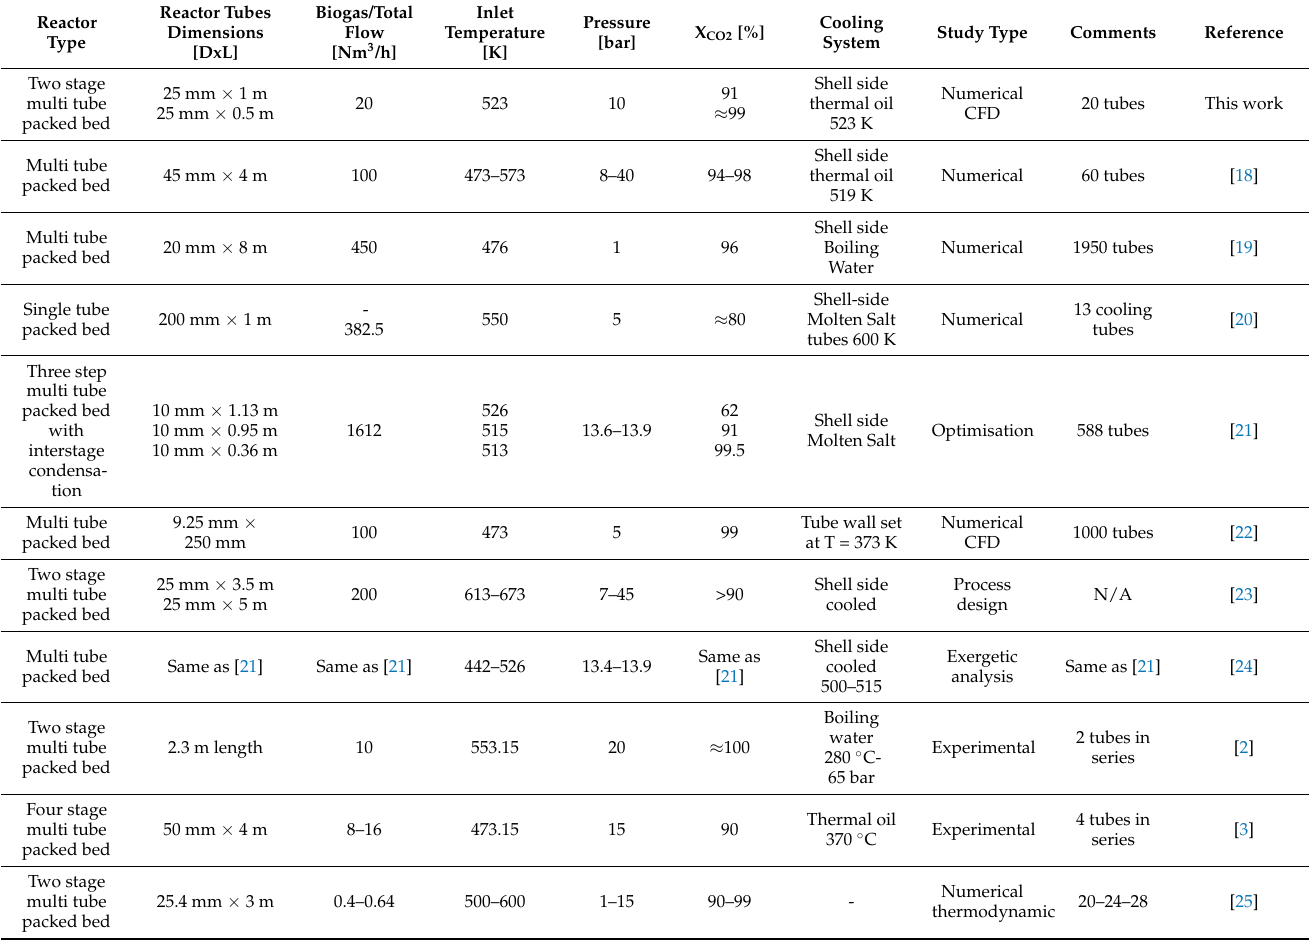
Table 2. Comparison of industrial sized biogas methanation